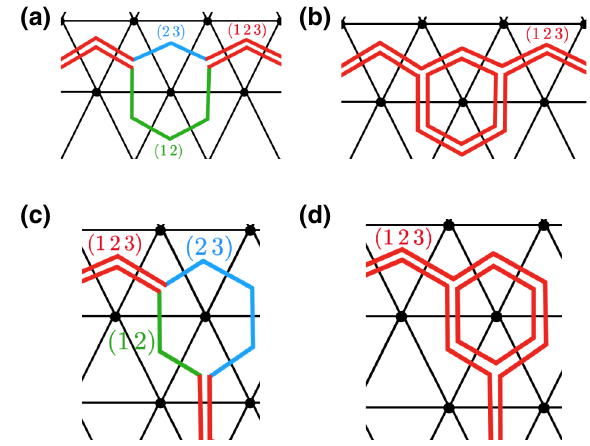
FIG. 15. Splitting of an S 3 domain wall. The leading correc- tion to the behavior is given by the process shown in (a). The remaining processes are parametrically smaller than this lead- ing correction. As an example, the weights of processes (b)–(d), relative to the weight of a composite ( 1 2 3 ) domain passing / J 2 = g 2 q − 2 α + · · · , through the region are given by (b) J 2 1 8